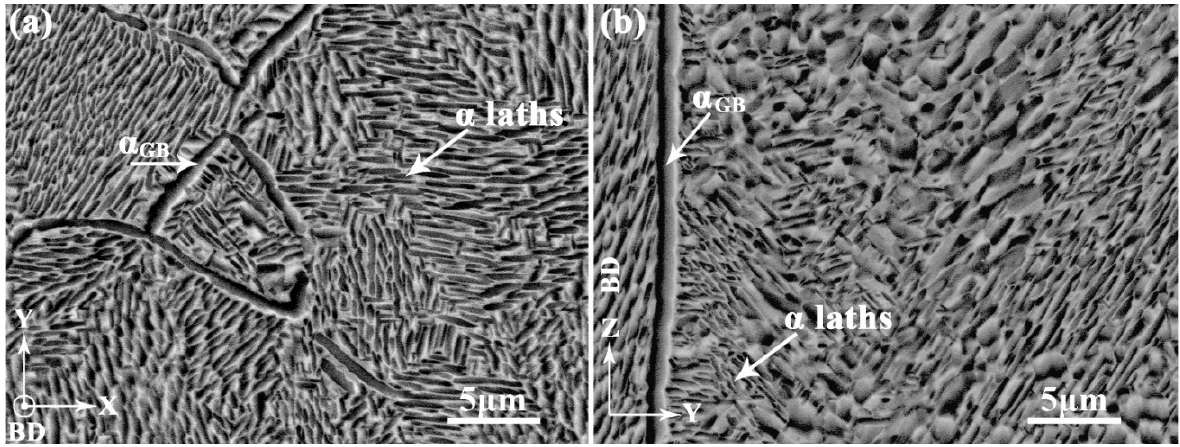
Figure 10. The SEM images of sample H-X in ( a ) XY- and ( b ) YZ-planes. The EBSD maps of the aged samples at the XY- and YZ-planes are shown in Figure 11a,b, respectively. Although a large number of β phases were transformed to α laths, the prior- β grains still remained in the XY- and YZ-planes. This is depicted in Figure 11a,b. Combined with the XRD results (Figure 6), the α phase content of sample H-X, which can be obtained by EBSD analysis, is about 76.9%. Figure 11c,d are the boundary misorientation distribution of the XY- and YZ-planes, respectively. After the aging treatment, the fraction of LAGBs (lower than 15 ◦ ) were reduced from 79.2% to 31.1% in the XY-plane and 80.7% to 30.9% in the YZ-plane, respectively. This implies the selective orientation of misorientation angles was greatly reduced. According to the XRD analysis, the prior- β phase texture is weakened after the aging treatment due to the nucleation of the α phase with weak texture [10,11]. This could be a reason for the reduction of LAGBs and selective ori- entations.